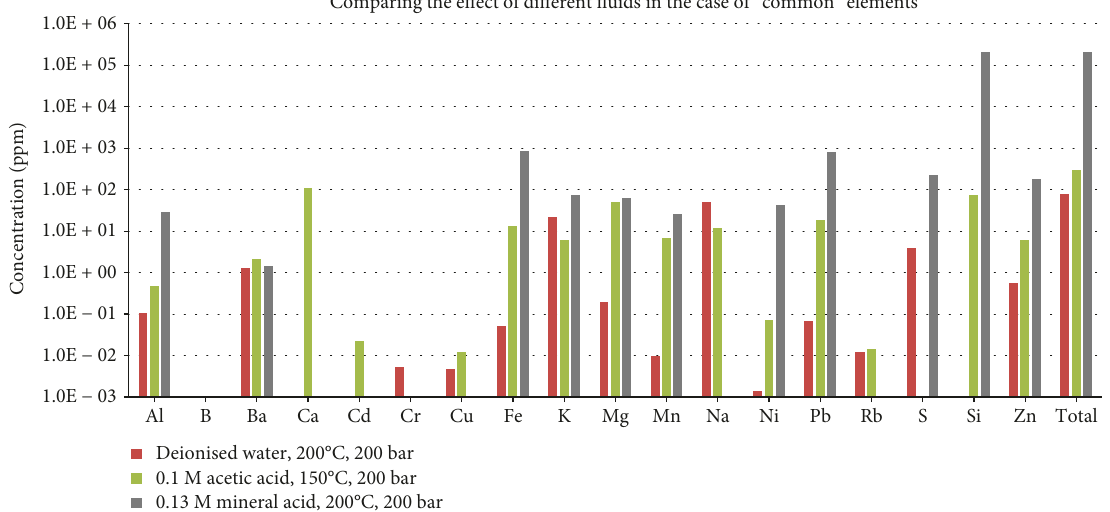
Figure 17: Comparison of the e ff ectiveness of di ff erent fl uids for “ common ” elements with concentrations in